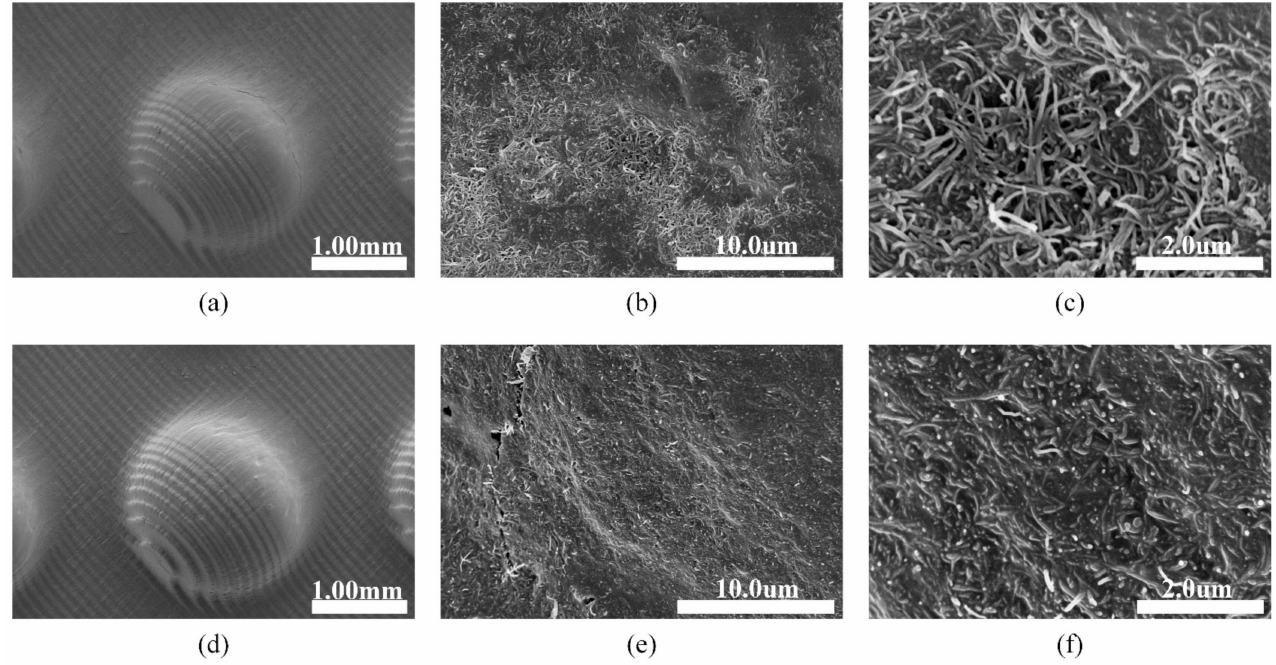
Figure 12. SEM images of sensors before ( a – c ) and after ( d – f ) the test: ( a , d ) Surface of the structure; ( b , c , e , f ) Top of the hemisphere under higher